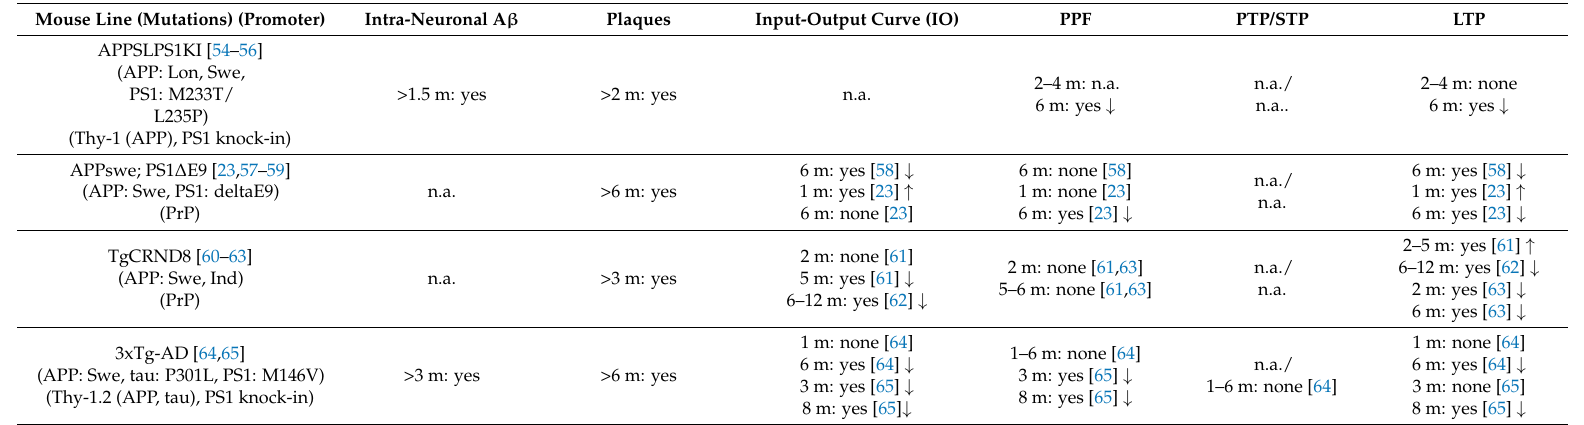
Mouse Line (Mutations) (Promoter) Intra-Neuronal A β